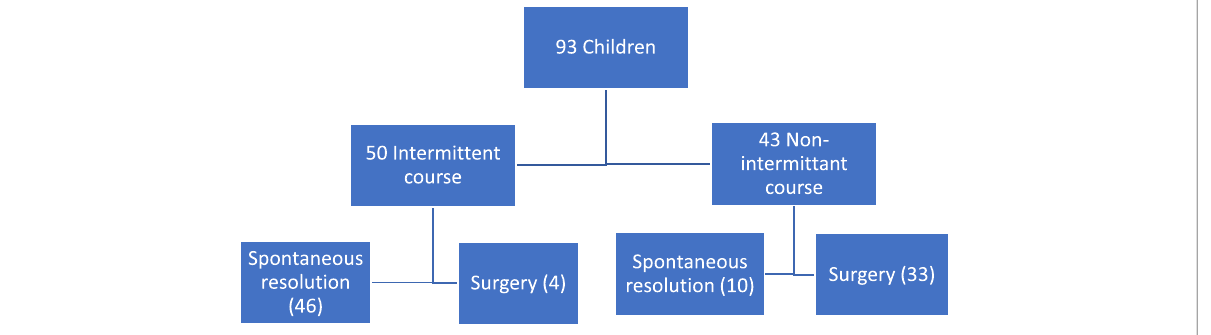
Fig. 2 Flow chart of children according to the course